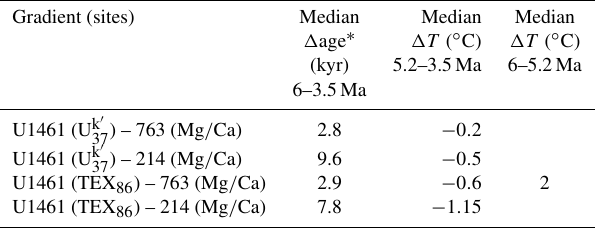
∗ Median (cid:49) age is calculated from the absolute difference between the IODP Site U1461 sample ages and the closest available sample ages from ODP Site 763 and DSDP Site